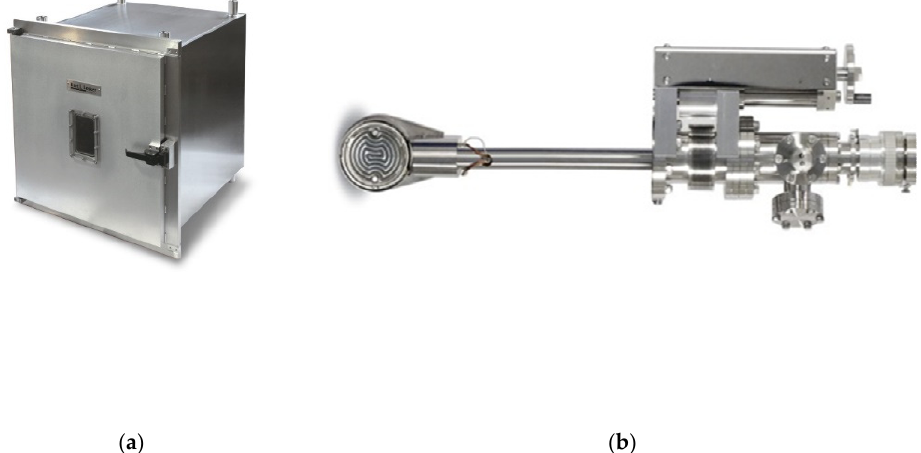
Figure 4. Photos of modules from the Kurt J. Lesker Company. ( a ) The ultra-high vacuum chamber [38]; ( b ) the EC-R Series manipulator [39].